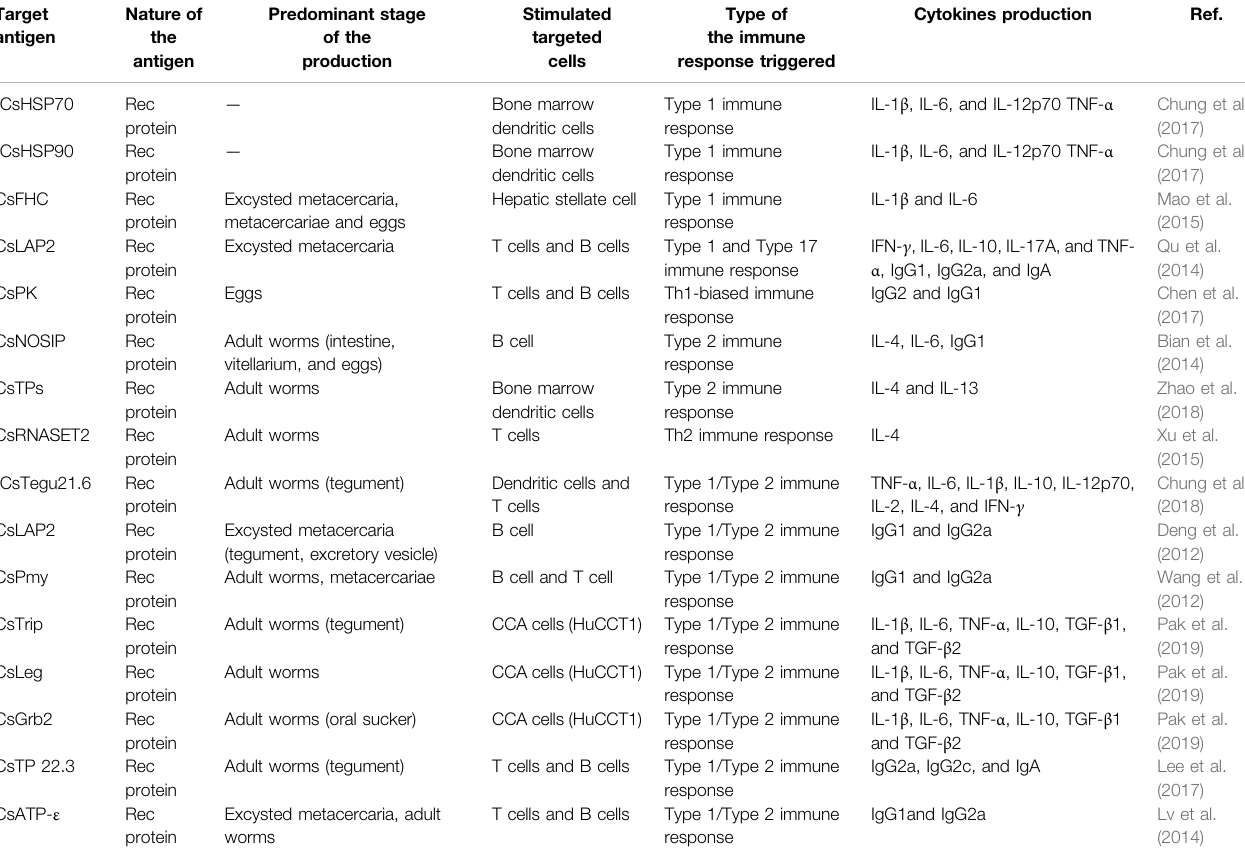
TABLE 1 | The candidates of potential vaccines against Clonornchis sinensis